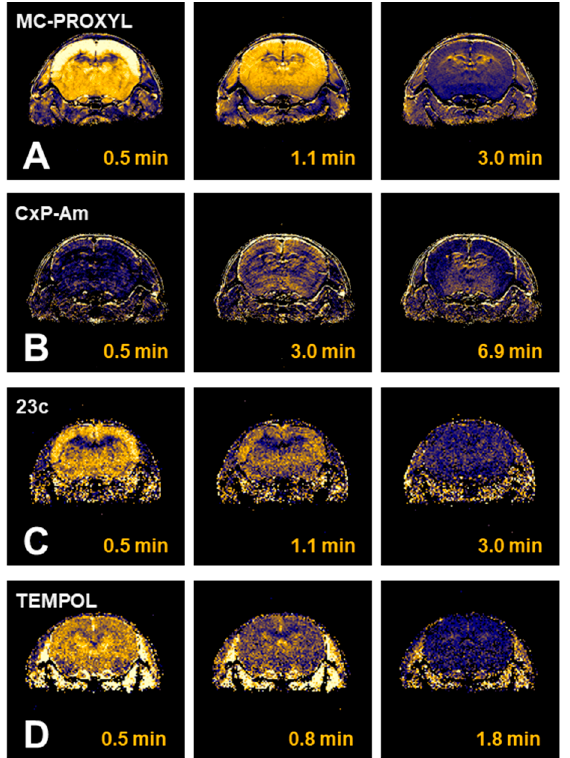
Figure 13. Distributions of nitroxyl contrast agents in mouse brain. T1-weighted signal enhancement images of mouse head were obtained after i.v. injection of ( A ) MC-PROXYL, ( B ) CxP-Am, ( C ) 23c, and ( D ) TEMPOL. Horizontal row showed the time course of the T 1 -weighted signal enhancement. The figures were partly modified from our previous reports [116].